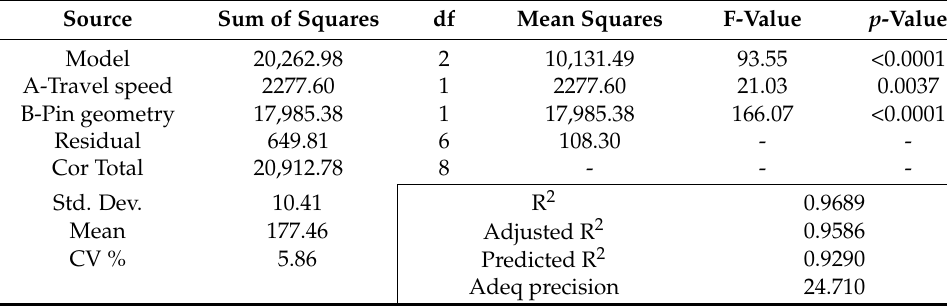
Table 6. ANOVA for surface roughness of AA1050 BT-FSP specimens.